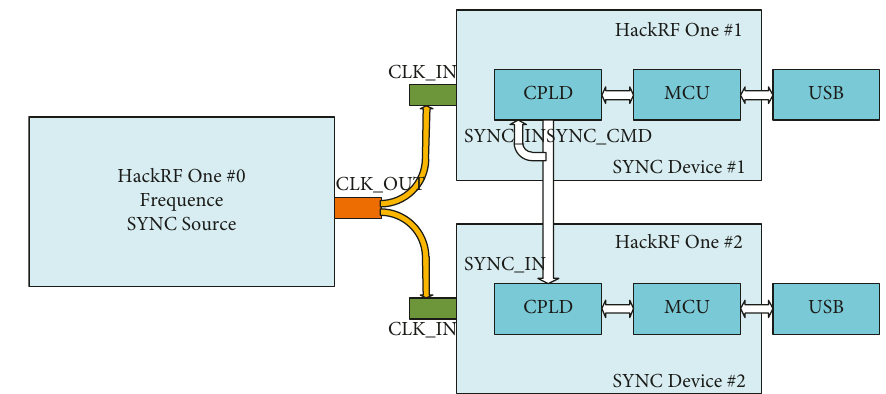
Figure 3: System block diagram.